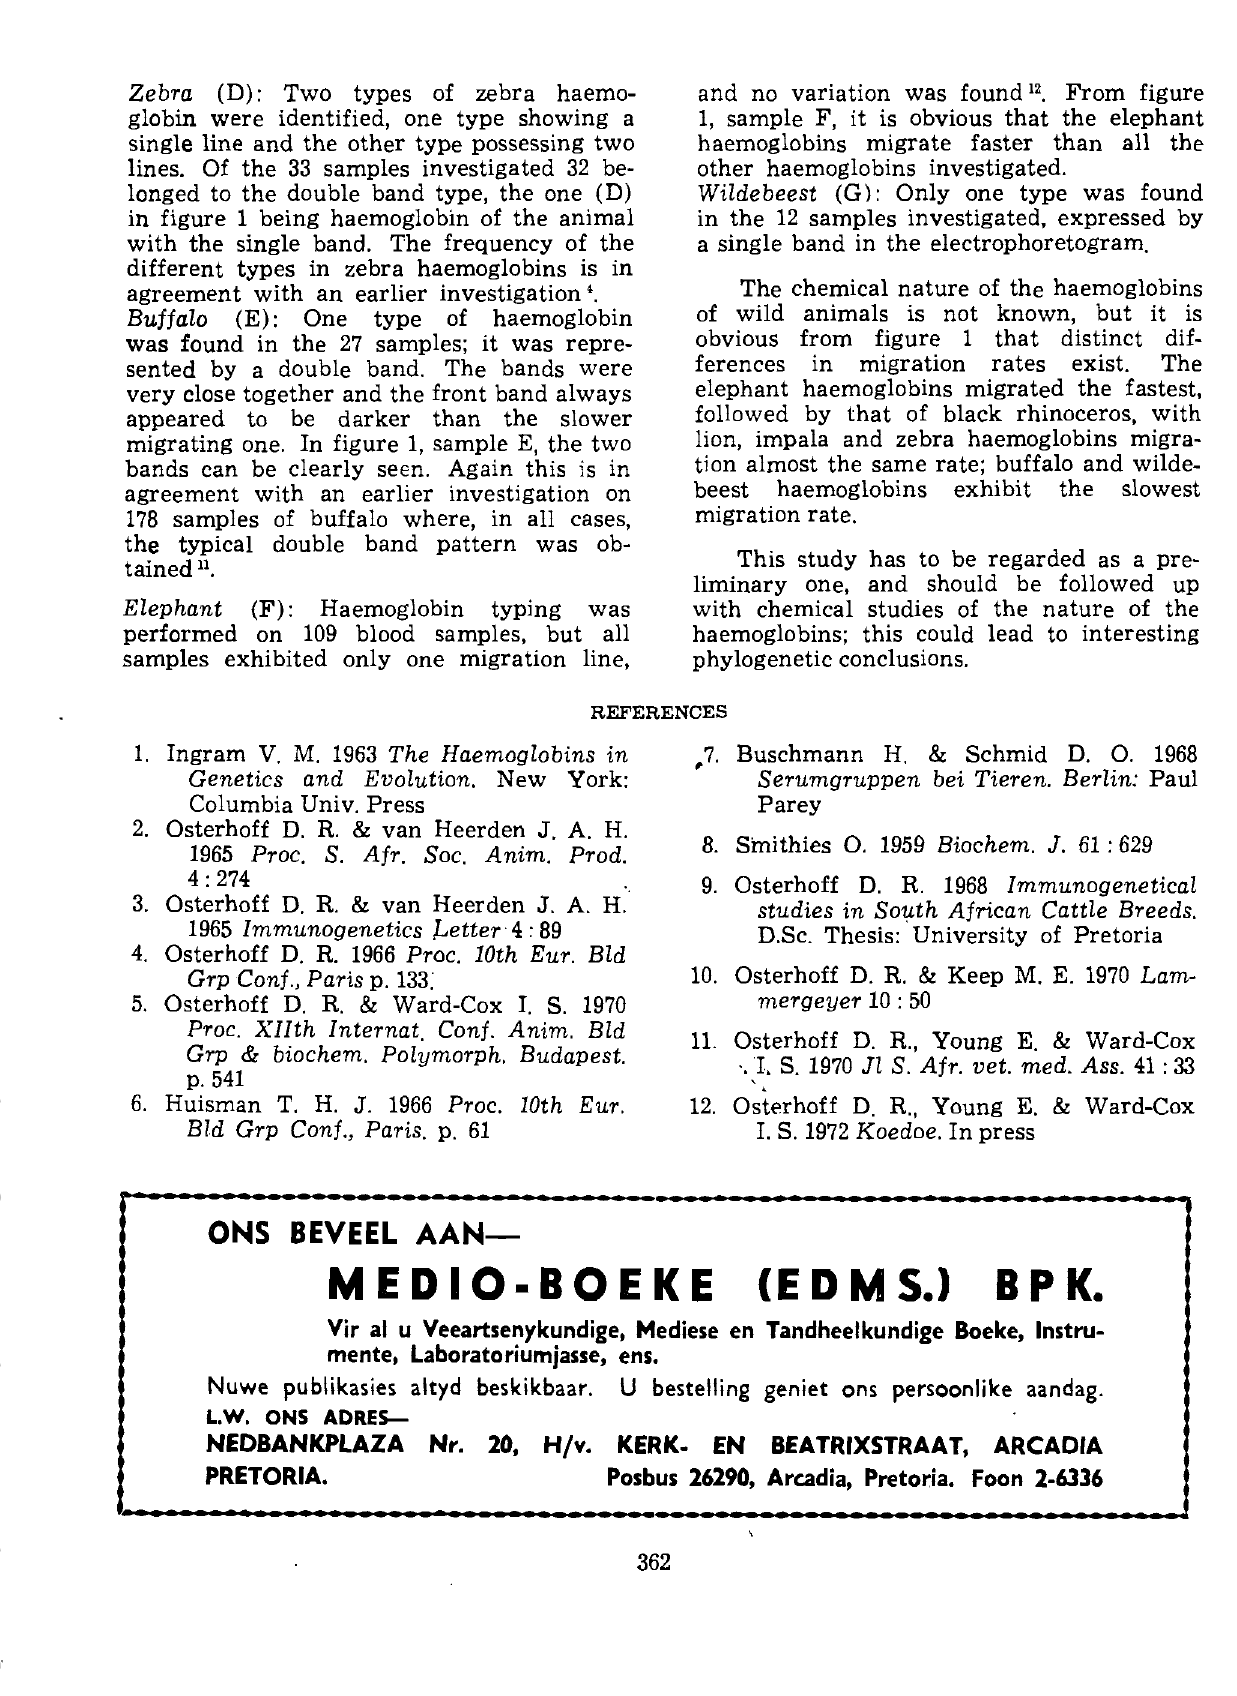
Zebra (D): Two types of zebra haemo globin were identified, one type showing a single line and the other type possessing two lines. Of the 33 samples investigated 32 be longed to the double band type, the one (D) in figure 1 being haemoglobin of the animal with the single band. The frequency of the different types in zebra haemoglobins is in agreement with an earlier inVestigation '. Bu.ffalo (E): One type of haemoglobin was found in the 27 samples; it was repre sented by a double band. The bands were very close together and the front band always appeared to be darker than the slower migrating one. In figure 1, sample E, the two bands can be clearly seen. Again this is in agreement with an earlier investigation on 178 samples of buffalo where, in all cases, the typical double band pattern was ob tained 11. Elephant (F): Haemoglobin typing was performed on 109 blood samples, but all samples exhibited only one migration line,